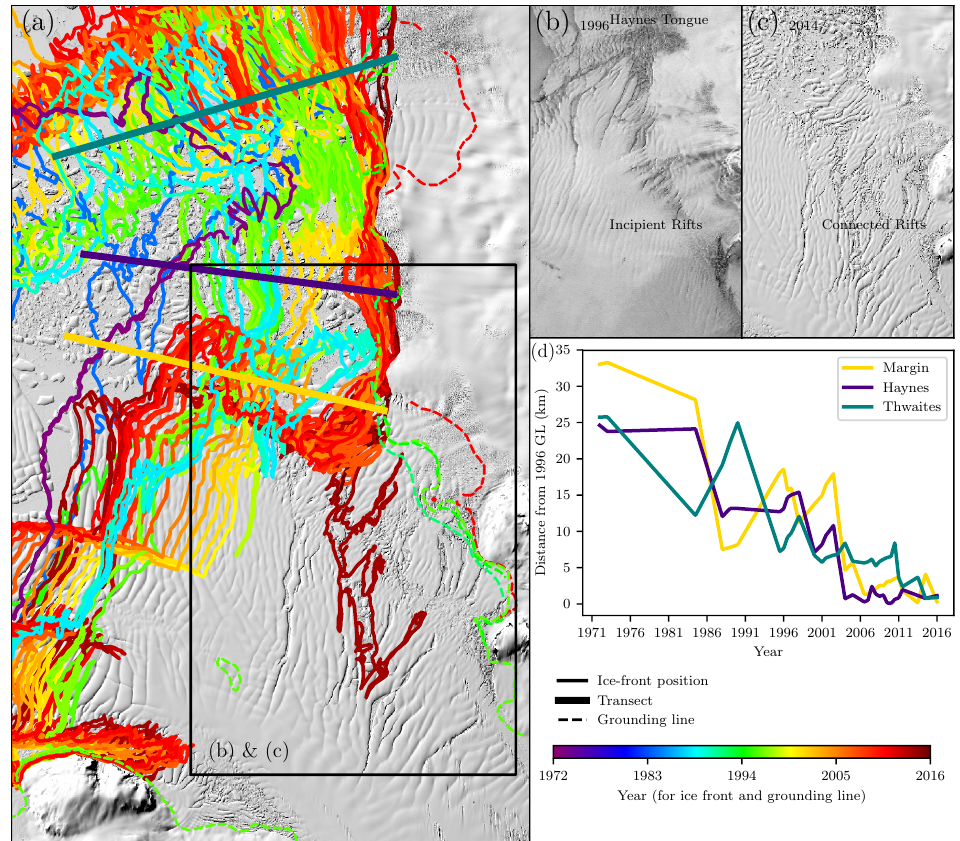
Figure 4. Crosson Ice Shelf front position. (a) Selection of digitized shelf-front positions from MacGregor et al. (2012) and from our work, with grounding lines from Rignot et al. (2014). Teal, purple, and gold overlays correspond to transects used for panel (d) . Box shows the outline of zoomed in area for panels (b) and (c) . (b) and (c) Zoomed in Landsat imagery from 1996 and 2014, respectively. Isolated rifts in 1996 appear connected by 2014, effectively detaching Crosson from its eastern margin. The disintegration of the Haynes Glacier tongue also occurred during this period. (d) Time series of ice-shelf-front distance relative to the 1996 grounding